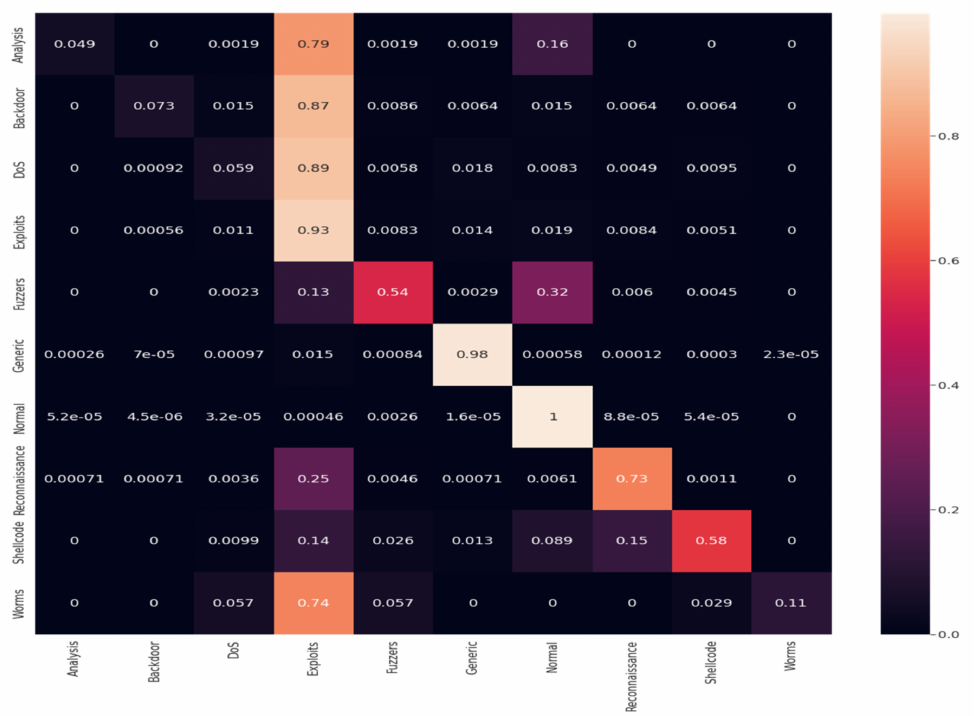
Figure 15. The confusion matrix for 10 classes in the Inception Time validation using the UNSW-NB15 dataset: normal, exploits, generic, fuzzers, reconnaissance, DoS, backdoor, analysis, shellcode, and worms; all values between 0.53 and